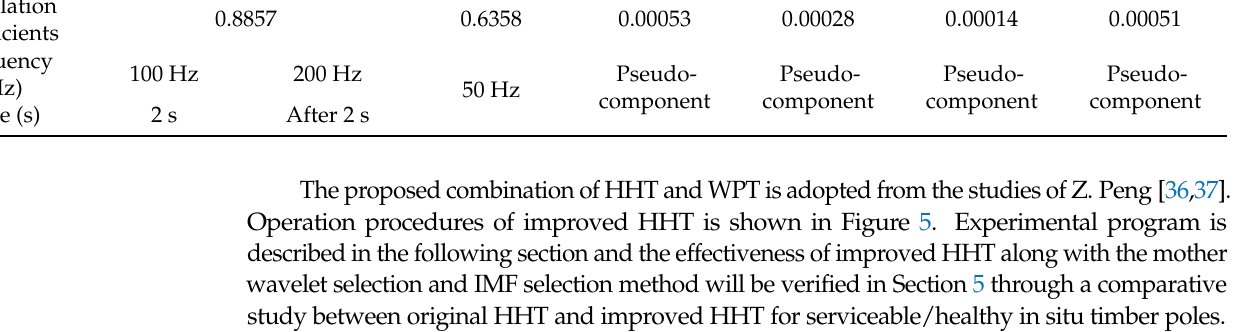
Table 2. The correlation coefficients of the IMFs and the multicomponent nonstationary signal (Figures 1–3). IMFs